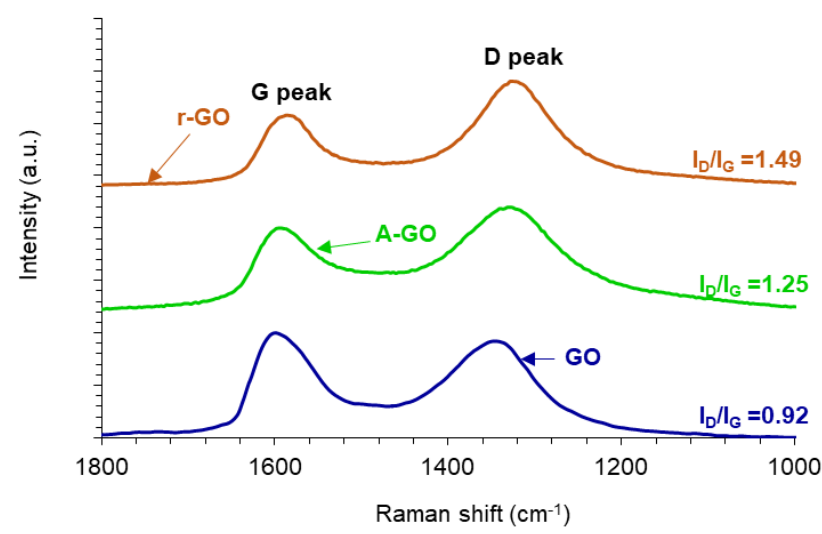
Figure 6. Raman spectra of the graphene oxide derivatives.